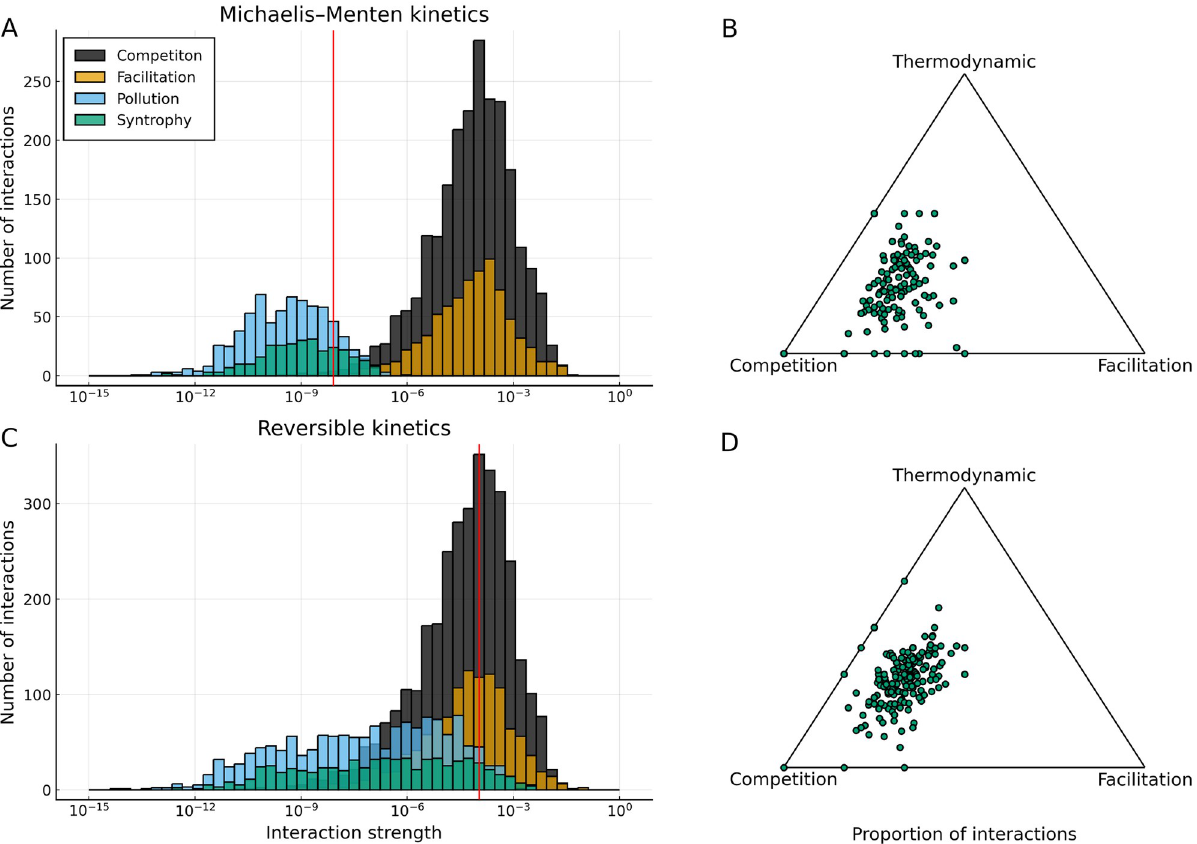
Fig 5. Thermodynamic and conventional interactions can be of comparable strength. A : Histogram of strengths of the four interaction types (shown schematically in Fig 1D). The vertical red line marks the point where the distribution of the strengths of the pollution interaction is at half its maximum. A clear separation of strengths between conventional and thermodynamic interactions can be observed. B : Simplex showing the relative proportions of competition, facilitation and the thermodynamic (pollution and syntrophy) interaction types. Each point represents one out of the 250 communities we simulated for each regime. Competition is by far the most common interaction type, with thermodynamic and facilitation interactions being similarly common. C : Corresponding plot to Fig 5A for reversible kinetics. Thermodynamic and conventional interactions now reach comparable strengths. D : Corresponding plot to panel B for reversible kinetics. Competition remains the most common interaction type, but thermodynamic interactions are now marginally more common than facilitation. All cases considered here are for low free-energy (recalcitrant) substrates (1.5 × 10 6 J mol − 1 ).